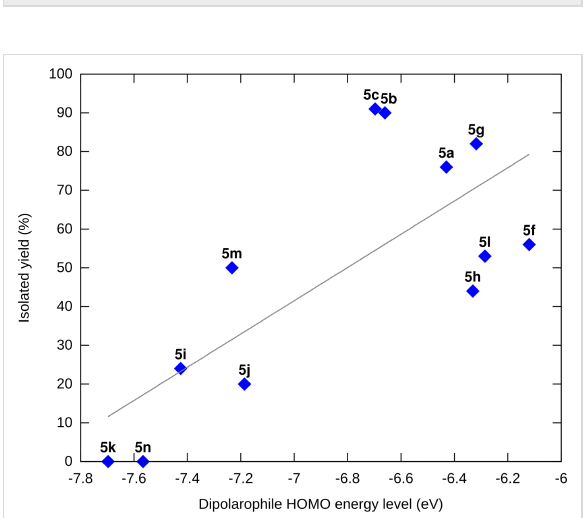
Figure 6: Yields of the cycloaddition reaction plotted against the HOMO energy levels of the dipolarophile partner among 5a – c , f – n .